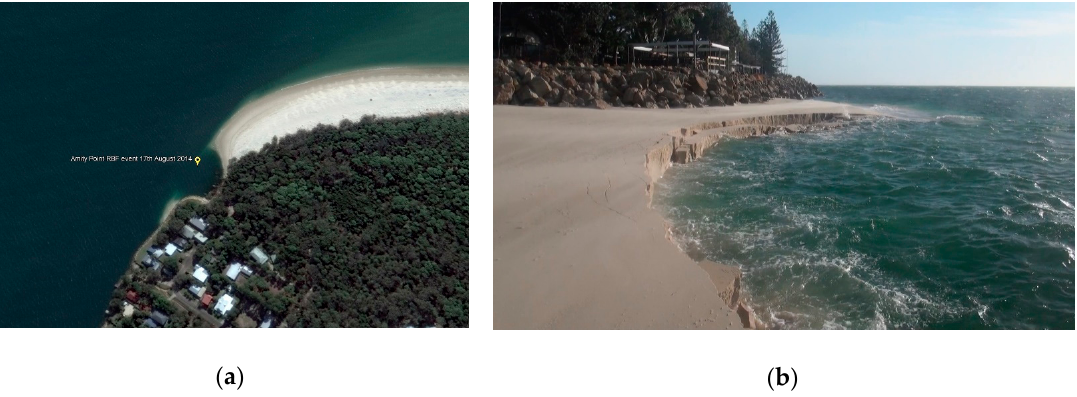
Figure 8. ( a ) Satellite image of an RBF crater at Amity Point captured on 18 August 2014 (Google Earth). ( b ) Image of this active event reaching the beach on 17 August 2014 viewed to the South. Beinssen, 2014 [1].